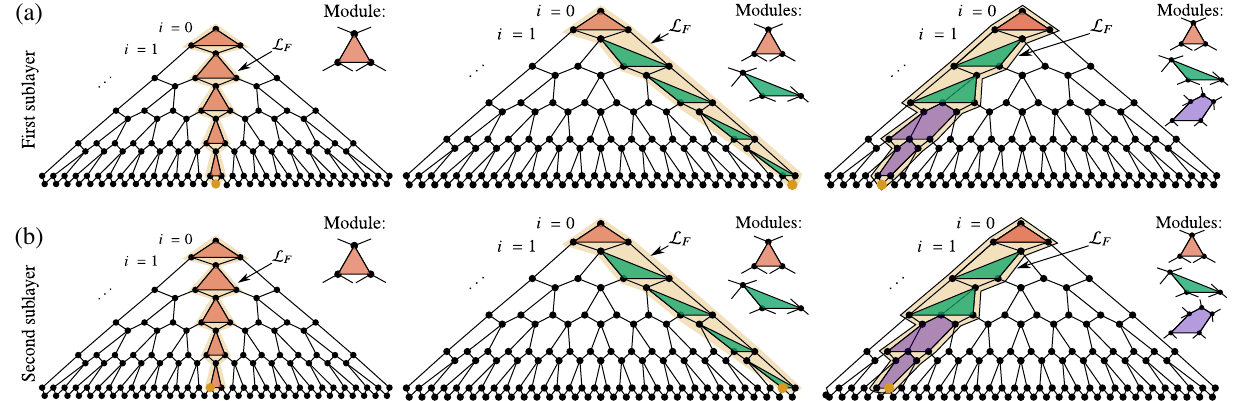
using three basic modules repeated F